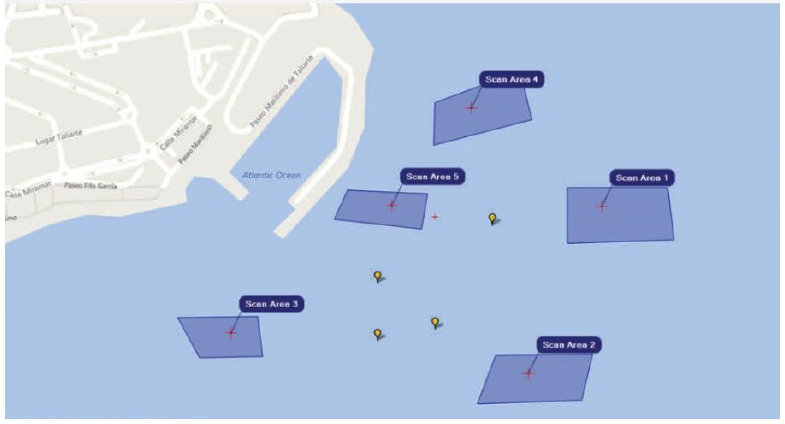
Figure 2. Real simulation setup deployed in Gran Canarias (Spain).